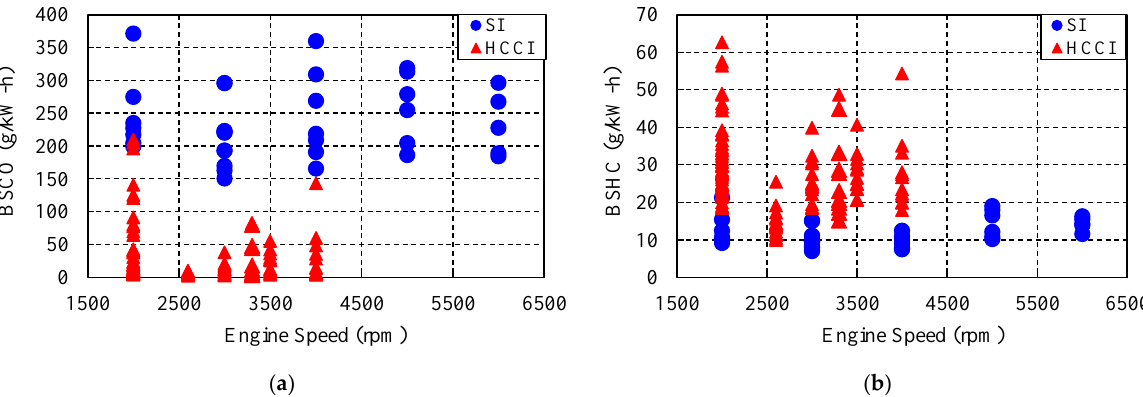
Figure 21. Comparison of exhaust emissions between proposed HCCI and original SI engine: ( a ) BSCO; ( b ) BSHC.